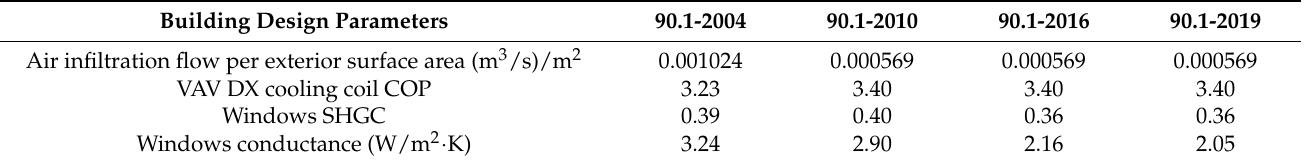
Table 10. Some of the design parameters of the DOE medium office building models in